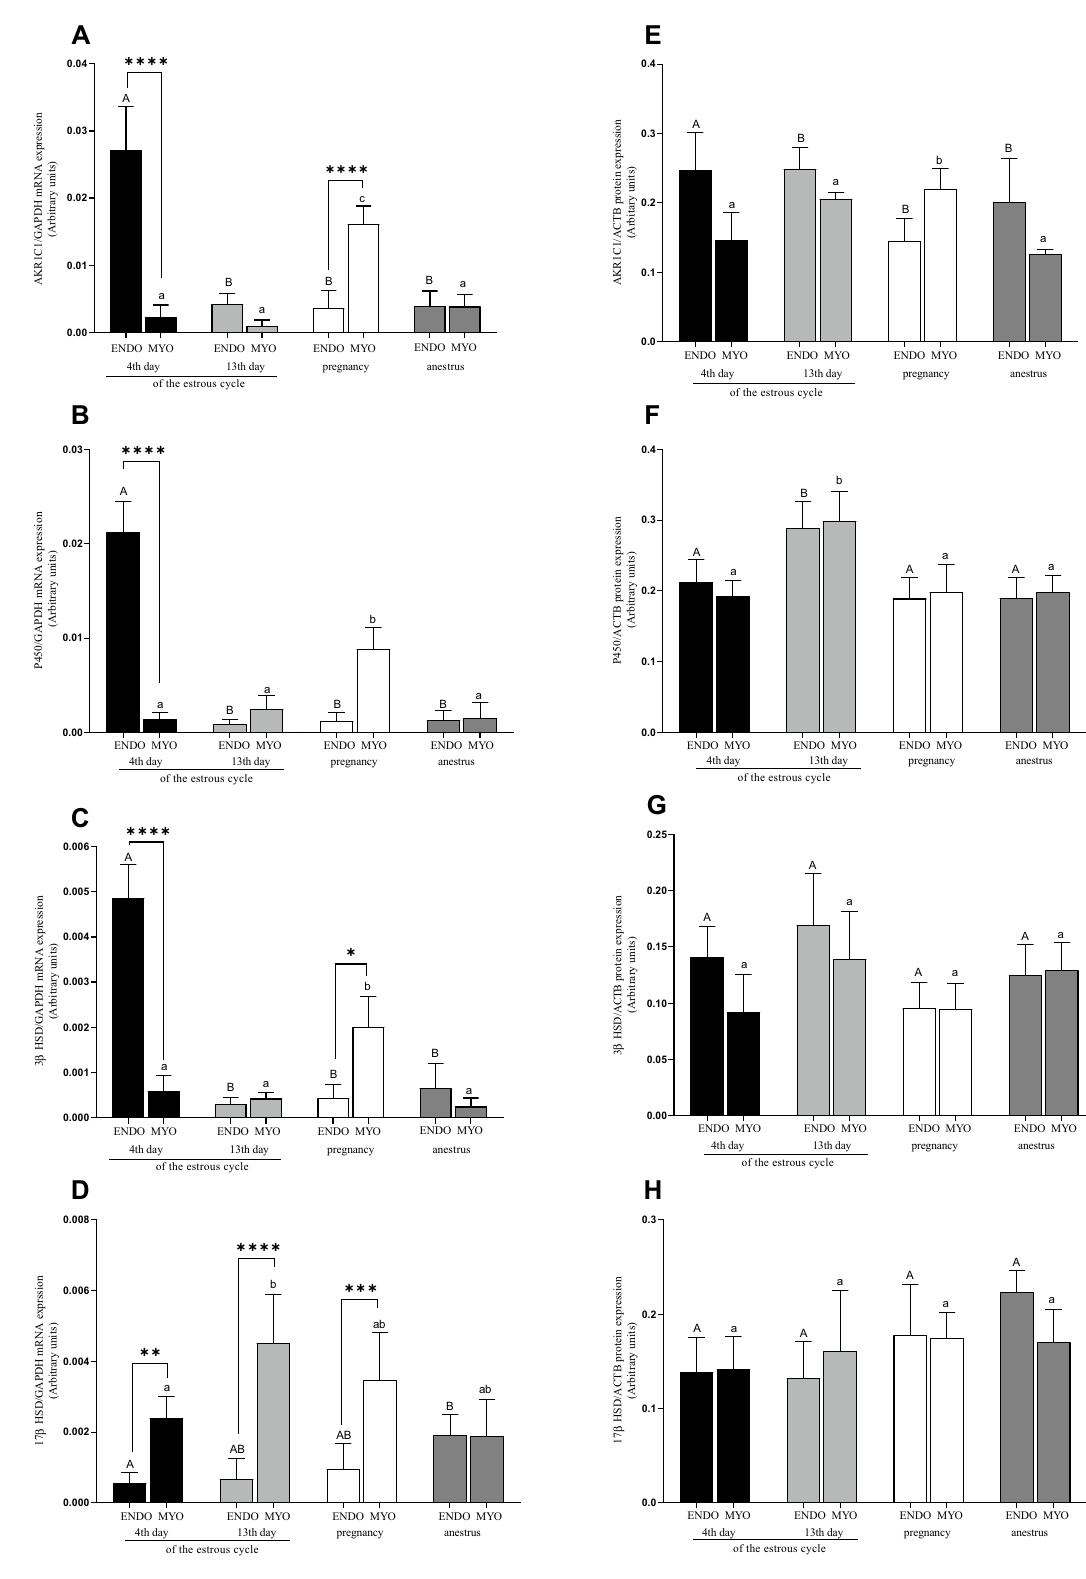
Figure 1. mRNA and protein expression of AKR1C1 ( A , E ), P450 ( B , F ), 3β-HSD ( C , G ) and 17β-HSD ( D , H ) in uterine tissues (endometrium and myometrium) on 4th and 13th day of estrous cycle, in pregnancy and anestrus phase. Data were normalized against GAPDH for mRNA expression and against β-actin (ACTB) for proteins expression. Each bar represents one experimental group with SEM. Statistical differences were analyzed by two-way analysis (ANOVA) of variance followed by the Bonferroni post hoc test using GraphPad PRISM (Version 8.3.0). The lowest statistical significance was P < 0.05. Asterisks indicate statistical differences between endometrium and myometrium (* P < 0.1; ** P < 0.01; *** P < 0.001; **** P < 0.0001). Different letters indicate statistical differences ( P < 0.05) between the experimental groups throughout endometrium (A, B) and myometrium (a–b)